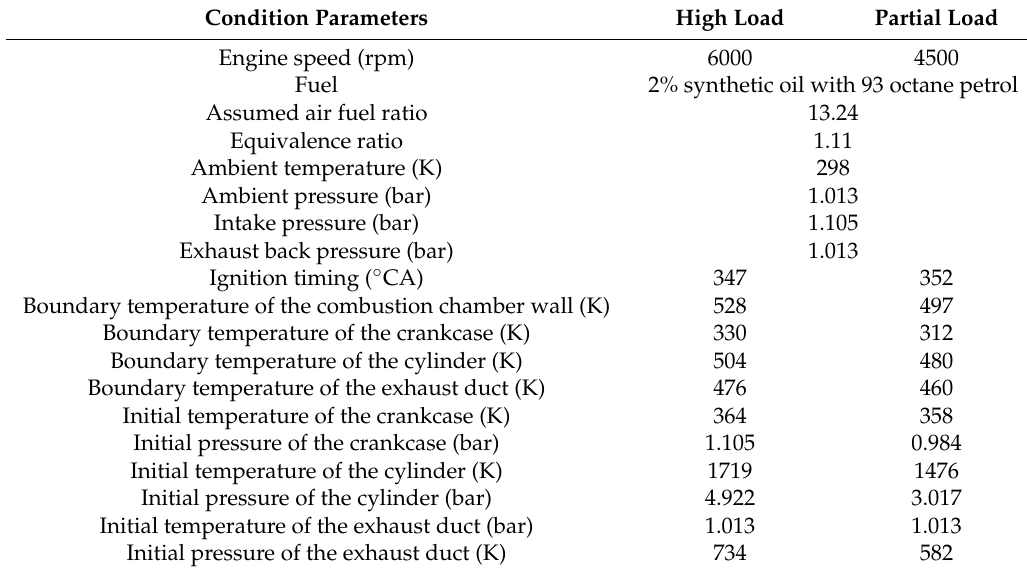
Table 2. Main specifications and condition parameters in AVL FIRE.